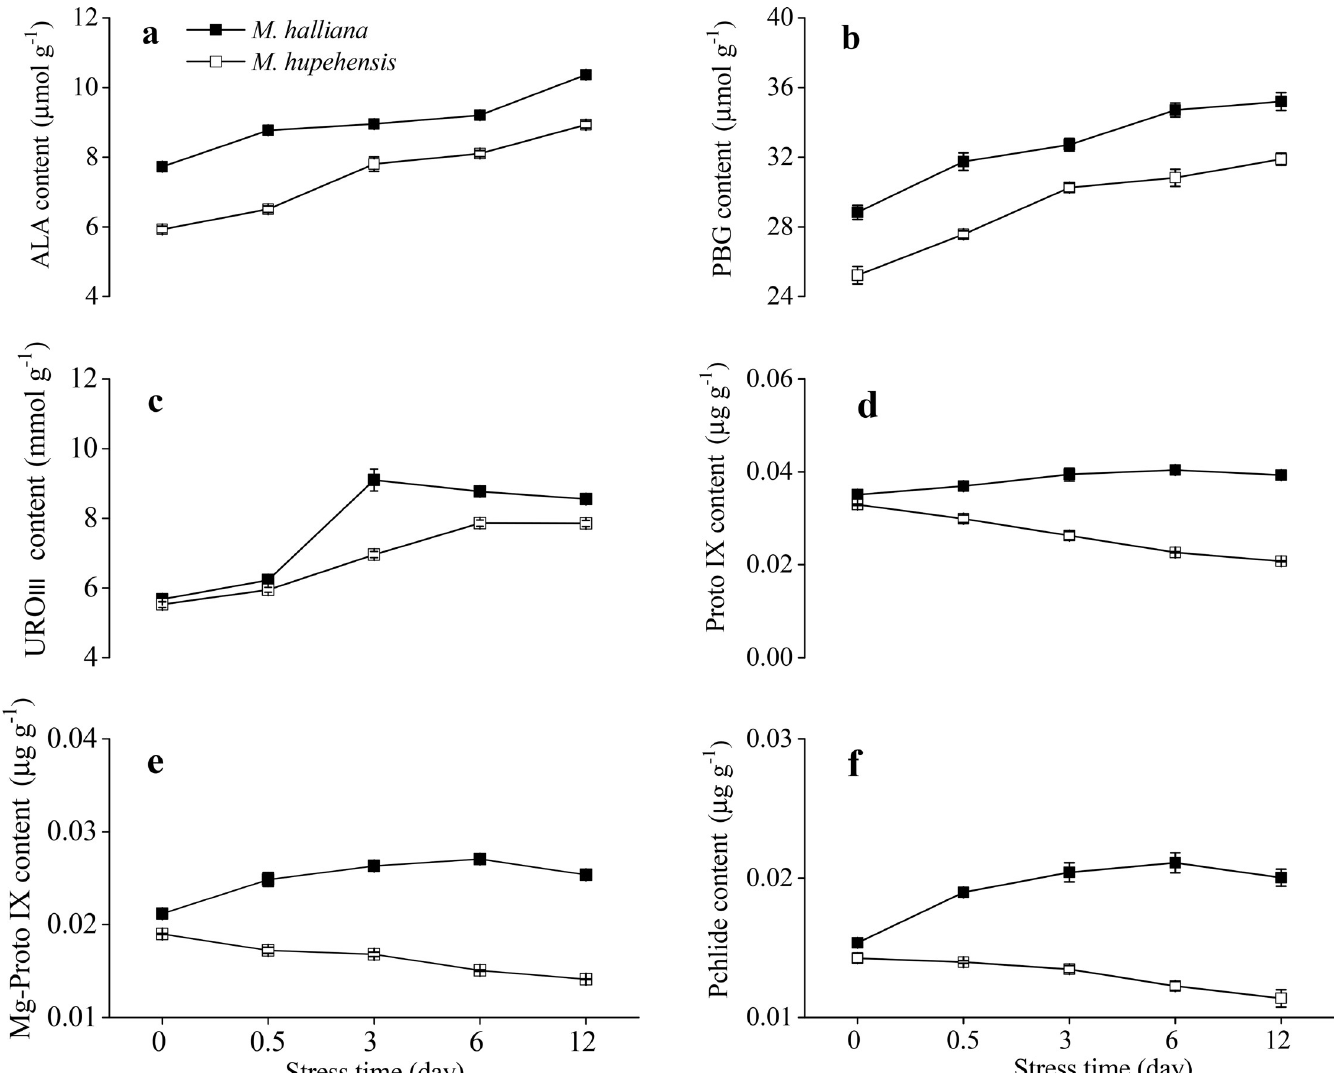
Fig 1. Effects of Fe deficiency on Chl precursor contents in the leaves of M . halliana and M . hupehensis . The seedlings underwent Fe deficiency for 0, 0.5, 3, 6, and 12 d as indicated. (a) ALA content. (b) PBG content. (c) URO III content; (d) Proto IX content. (e): Mg-Proto IX content. (f): Pchlide content. Vertical bars represent the mean ± SD value from three temporal replicates (n =